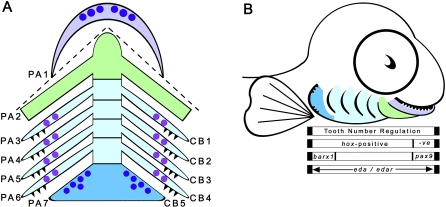
Teleost Pharyngeal Arches Exhibit Teeth on Old and New Jaws(A) Schematic diagram of the lower pharyngeal arches in an embryonic (∼7 dpf) cichlid fish (dorsal view).(B) Cartoon of the cichlid head showing pharyngeal arches (representing a general embryonic cichlid ∼7 dpf).(A and B) Oral jaw (PA1, lilac) houses a dentition (dark-blue circles) that develops in an ectoderm-influenced environment; dashed line in (A) represents the ectoderm/endoderm interface; a strict boundary may not exist due to cell mixing across this interface [36]. This dashed line also reflects the border between Hox gene–positive and Hox gene–negative oropharyngeal regions among vertebrates; we do not suggest a functional relationship between the two. The unique hyoid arch (PA2, green) is the only arch in the series that has no teeth (not a general rule for all fish) or gills/gill rakers; however, it does extend to cover all posterior arches as the opercular flap. PA3–6 (CB1–4, light blue) are gill-bearing arches (black triangles in [A]); these arches also house gill rakers (purple circles) that express a similar suite of genes during development in a similar temporospatial manner to the teeth on PA1 and PA7. Gill rakers will feature a secondary tooth/denticle set later in development. Oral and pharyngeal tooth development is generally governed by the same genetic regulators (see Figures 4 and 5); this corresponds to a positive correlation in the number of tooth units across the two disparate sites (tooth number regulation; see Figure 2). Pharyngeal tooth sites (PA7, blue) represent the first sites of tooth formation in vertebrates. The oral jaw and the teeth of PA1 develop devoid of hox gene expression (-ve), whereas the pharyngeal jaw and the teeth of PA7 (and all other arches in the series PA3–6) develop with hox genes strongly expressed in the pharyngeal mesenchyme around the forming pharyngeal jaw cartilages and teeth (hox positive; see Figure 3). pax9 is only expressed in relation to the dentition of the oral jaw, whereas barx1 is only expressed in relation to the dentition of the pharyngeal jaw (B). eda and edar are both expressed in a similar pattern throughout the entire pharyngeal arch series from the dentitions of the oral and pharyngeal jaw to the organization of the gill raker buds along the cartilage bars of PA3–6 (see Figure 5). Colors in (A) correspond to those in (B).